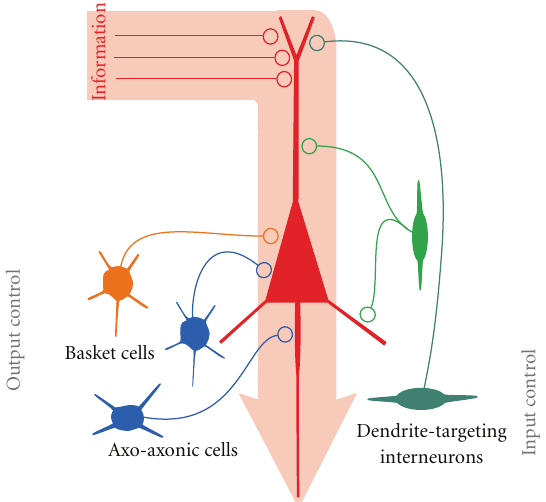
Figure 1: Oversimplified scheme of the inhibitory control of cortical pyramidal neurons by several general classes of GABAergic interneu- rons . Information (pink wide arrow) is transferred from excitatory glutamatergic synapses (red axon terminals) to the pyramidal neuron (red cell) dendrite. Excitation (information) travels along the dendritic tree to the soma and axon initial segment, where it could generate an action potential. Along this dendro-somatic- axonal axis, information can be di ff erently filtered by GABAergic synapses possessing specific basic and plasticity properties. On the left-hand side, interneurons controlling the output are illustrated as di ff erent classes of basket and axo-axonic cells. Di ff erent GABAergic interneurons controlling the input into pyramidal neurons are shown on the right, as impinging the dendrite(s) at di ff erent distances from the soma. Details in the